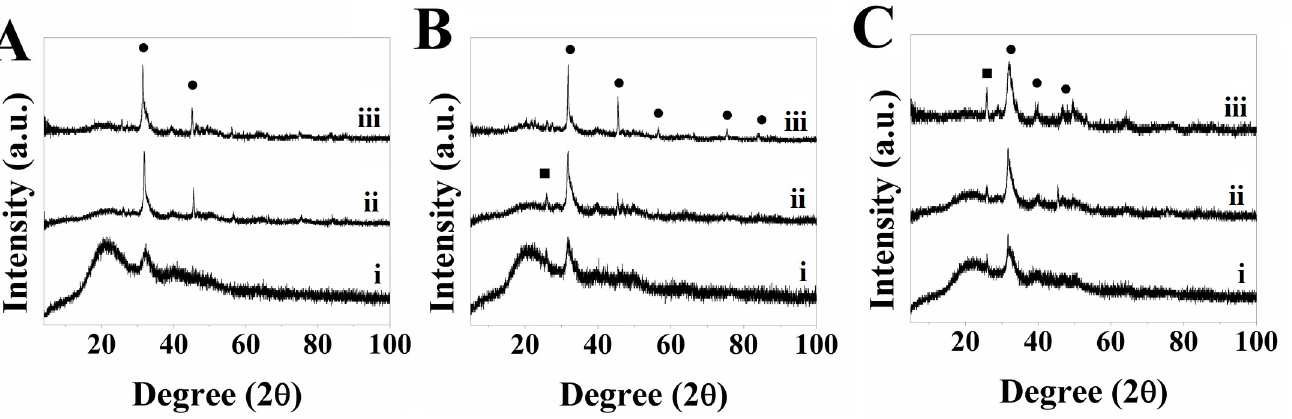
Fig 8. XRD pattern for A) DC, B) 1:10 DC-C s and C) 1:10 DC-C p hydrogels immersed in SBF at days i) 3, ii) 7, iii) 14 ( ● –HA corresponding to ICDD file 00-009- 0432, ■ –PE corresponding to ICDD file 00-060-1505).